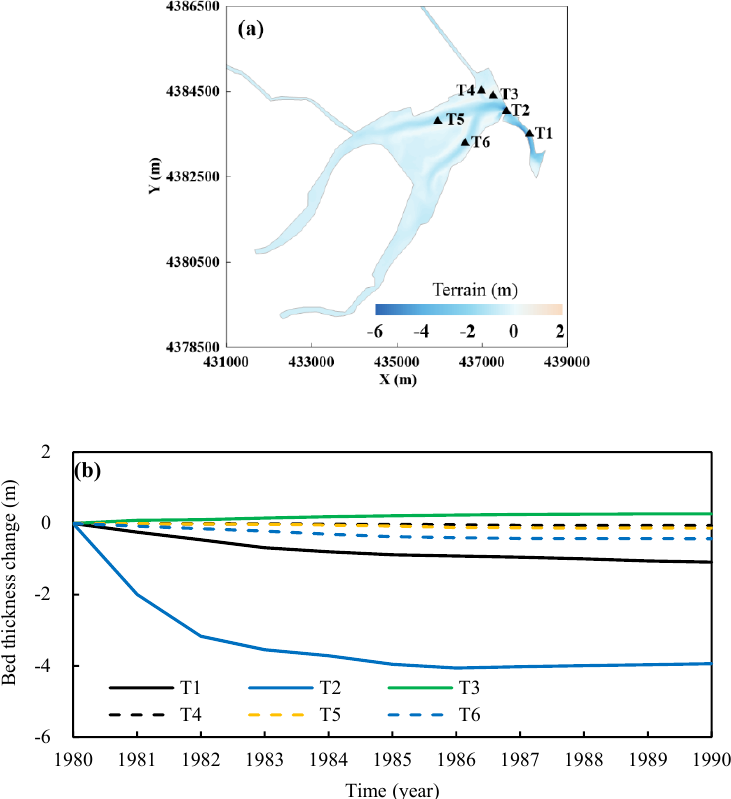
Figure 12. ( a ) Field observation stations T1 to T6; ( b ) bed thickness changes at the observation stations T1 to T6 from 1980 to 1990.